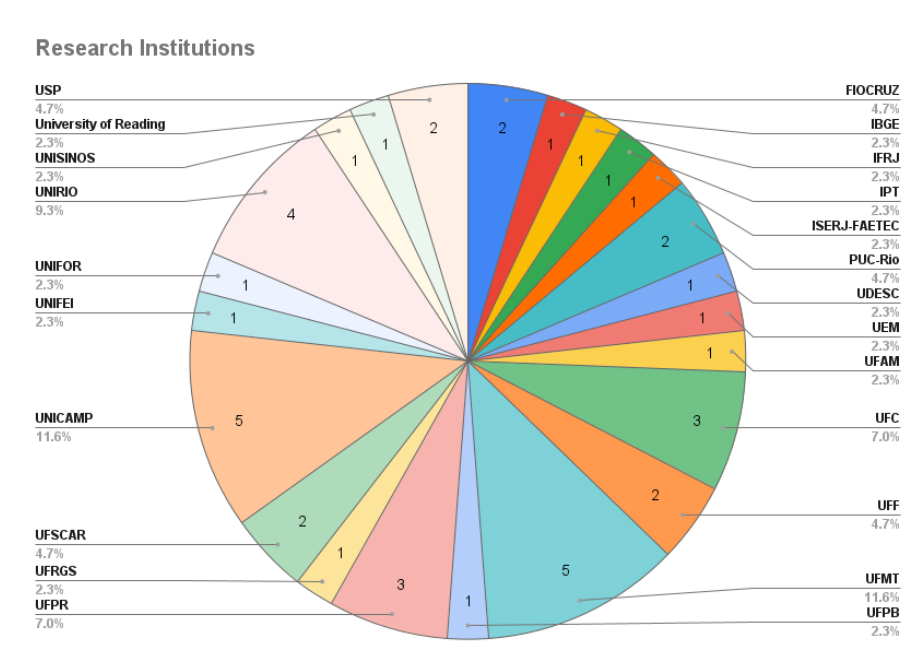
Figure 7. Institutions with at least two occurences.